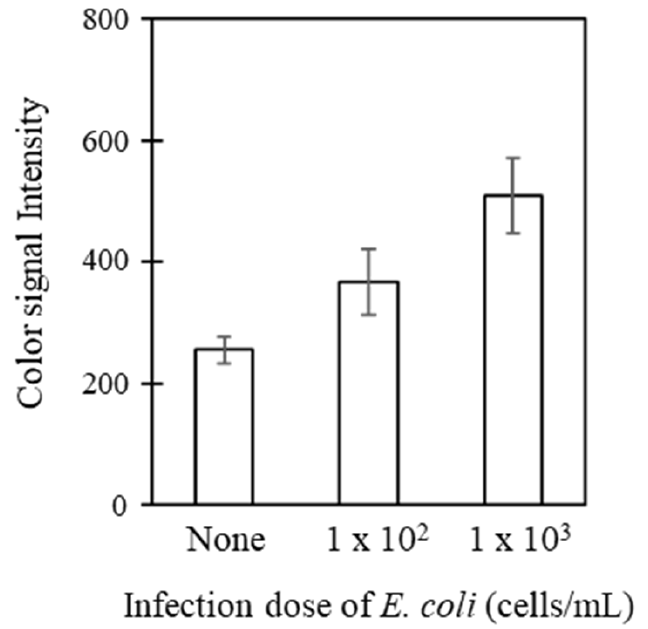
Figure 7. Analytical evaluation of the system with respect to infection by live bacteria. Host cells at 3 × 10 6 cells/mL were prepared on the membrane scaffolds and incubated for 4 days. Different concentrations of E. coli (0, 1 × 10 2 and 1 × 10 3 cells/mL) were inoculated and analyzed as described elsewhere.